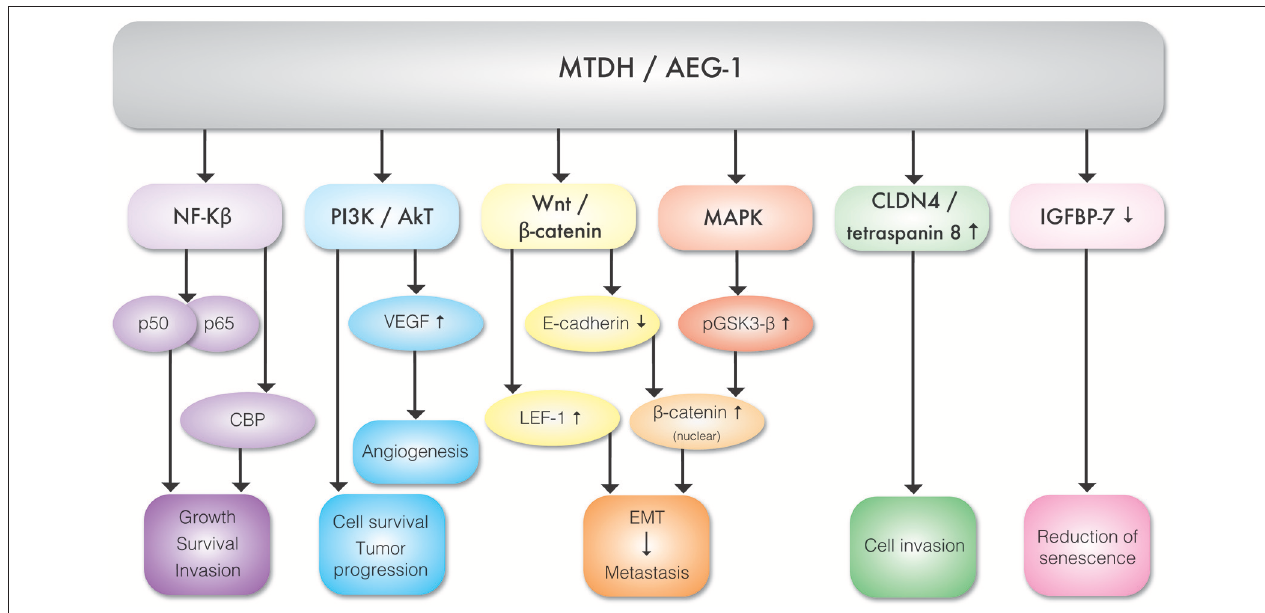
FIGURE 3 | Molecular interactions between MTDH/AEG-1 and various effector molecules of signal transduction pathways exhibiting different biological functions.